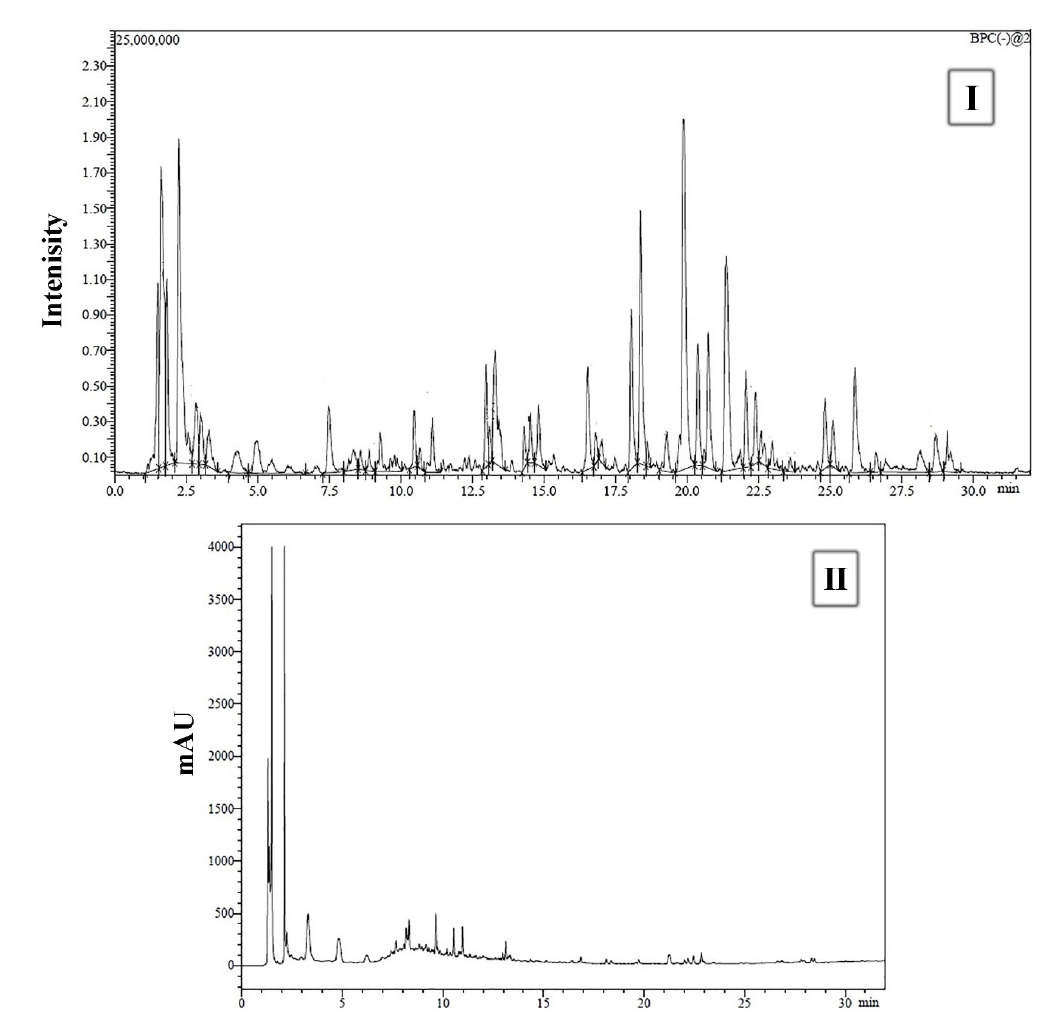
Figure 1. ( I ) UPLC-ESI-MS chromatogram of A. awamori aqueous ethanol extract in negative ionization mode. ( II ) UPLC- PDA chromatogram of A. awamori aqueous ethanol extract. Table 2. UPLC-PDA-MS/MS profiling data for A. awamori .